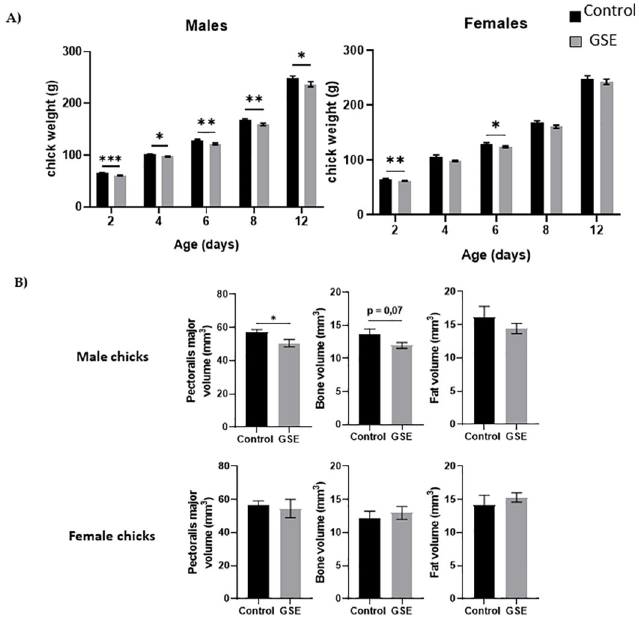
Fig 7. Body composition of the F2 chicks. ( A ) Body weight (g) of male and female chicks (F2) at hatching (D0) and 12 days of age (D12) from F1 control and F1-GSE hens (n = 60). ( B ) The pectoralis major muscle, fat and bone volume of male and female chicks were measured at day 12 of age (n = 10 animals/sex) by computed tomography. Results are presented as means ± SEM. � , p < 0.05. �� , p < 0.01. �� , p < 0.01.